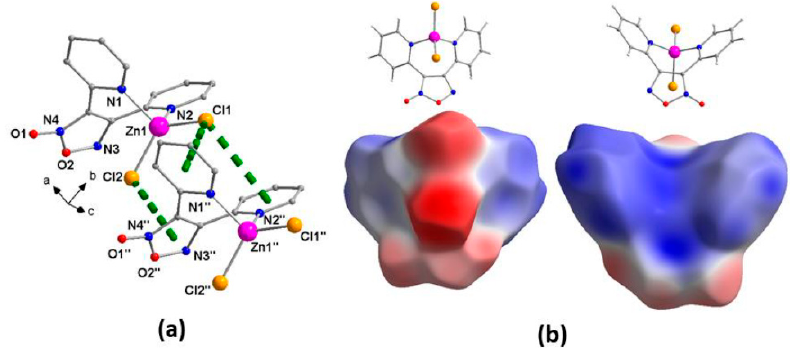
Figure 5. ( a ) Cl ··· π intermolecular interactions, indicated with thick, green dashed lines, in the crystal Figure 5. ( a ) Cl ⋯ π intermolecular interactions, indicated with thick, green dashed lines, in the crystal Figure 5. ( a ) Cl ⋯ π intermolecular interactions, indicated with thick, green dashed lines, in the crystal structure of [ZnCl 2 (L)] ( 1 ). Symmetry code: (‘’) x − 1, y , z . Hydrogen atoms have been omitted for clarity. structure of [ZnCl 2 (L)] ( 1 ). Symmetry code: (‘’) x − 1, y , z . Hydrogen atoms have been omitted for structure of [ZnCl 2 (L)] ( 1 ). Symmetry code: (‘’) x − 1, y , z . Hydrogen atoms have been omitted for ( b ) Front and back views of the HS decorated electrostatic potentials in the range from − 0.093 (red) to clarity. ( b ) Front and back views of the HS decorated electrostatic potentials in the range from − 0.093 clarity. ( b ) Front and back views of the HS decorated electrostatic potentials in the range from − 0.093 + 0.066 (red) to +0.066 (blue). (red) to +0.066 (blue). Figure 5. ( a ) Cl ⋯ π intermolecular interactions, indicated with thick, green dashed lines, in the crystal structure of [ZnCl 2 (L)] ( 1 ). Symmetry code: (‘’) x − 1, y , z . Hydrogen atoms have been omitted for clarity. ( b ) Front and back views of the HS decorated electrostatic potentials in the range from − 0.093 (red) to +0.066 (blue).